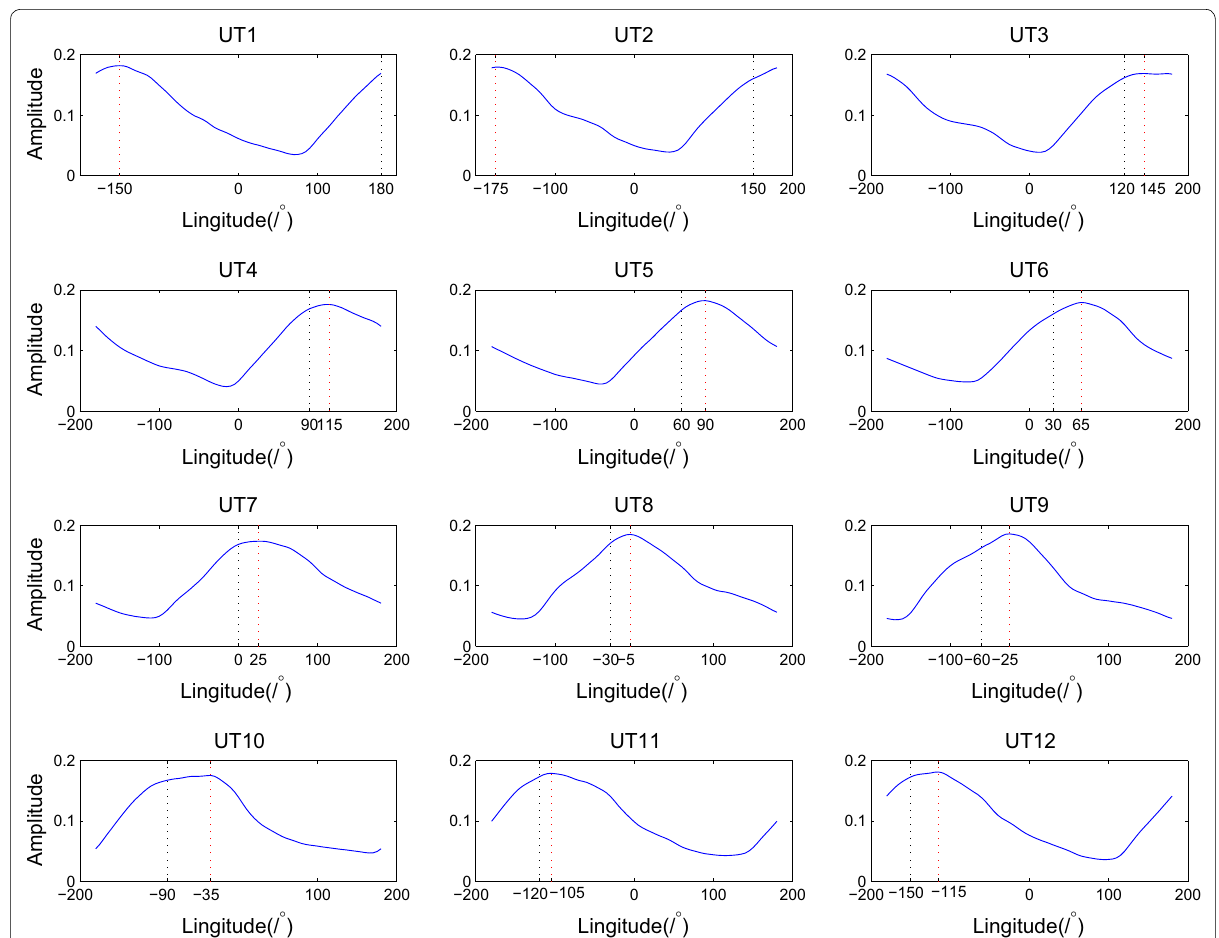
Fig. 3 The large-scale longitudinal variation in the ionosphere for the 12 UTs. The red dotted line indicates the longitude position of the maximum U ( 2 ) . The black dotted line indicates the longitude position of the maximum solar irradiation. The x-axis is the geographic longitude, ranging from − 180 ◦ to 180